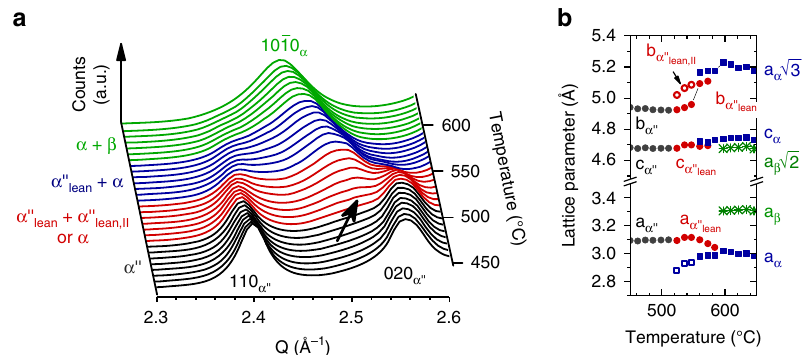
Fig. 5 Close-up of the temperature interval of martensite decomposition for Ti – 21Nb. a At 520 °C the diffracted intensity at Q ffi 2.52 Å − 1 increases corresponding to either (020) of a second orthorhombic component or to {101 ̅ 0} α . b The lattice parameters of the nucleating α ″ lean, II and α are indicated by open symbols